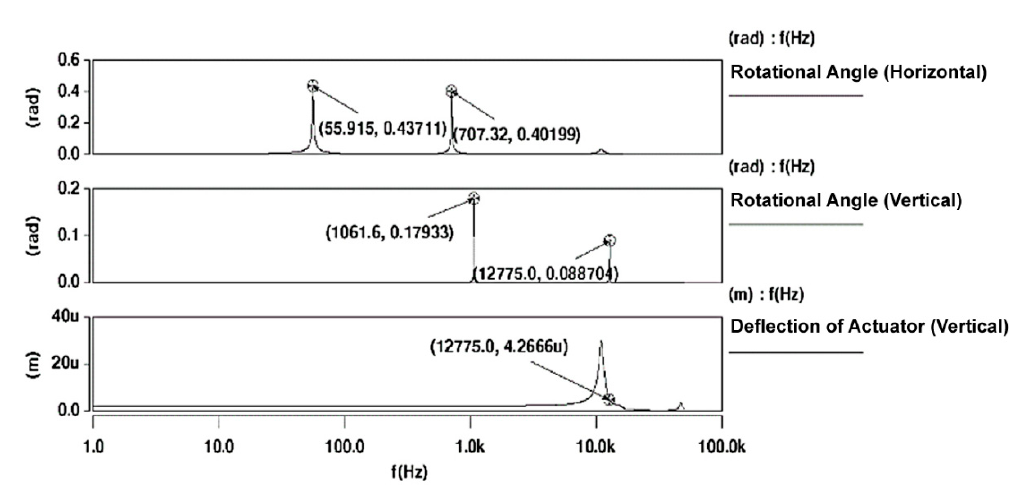
Figure 6. Architect3D in CoventorWare simulation results: ( top and middle ): deflection angle as a function of frequency and ( bottom ): deflection response of the actuator.